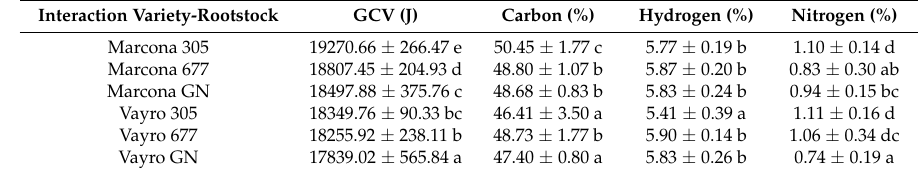
In the same column, mean values with different minor letters differ significantly ( P <